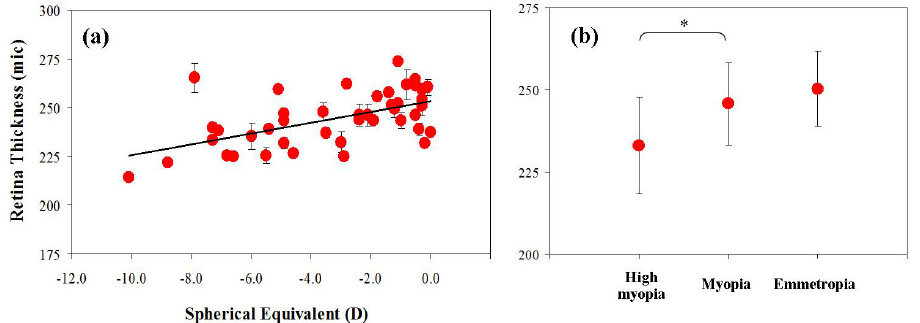
Figure 5. ( a ) Choroidal thickness as a function of the SE at the location N. ( b ) Averaged thickness values for each experimental group (*: p = 0.04). Error bars indicate the standard deviation in both panels. In some cases, left panel, the diameter of the experimental points surpasses the magnitude of the corresponding error bar.